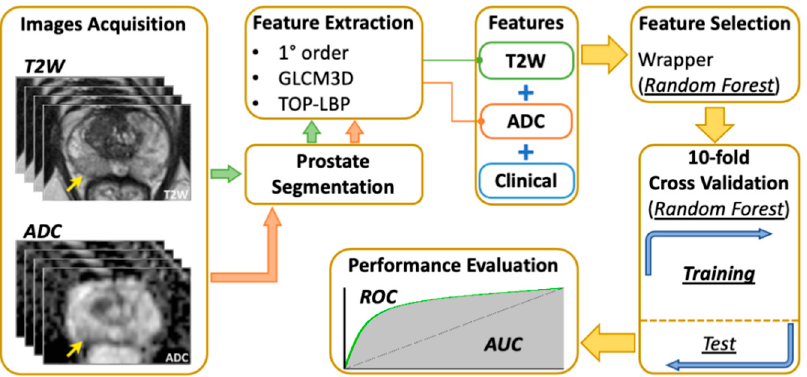
Figure 2. Machine-learning algorithm process.